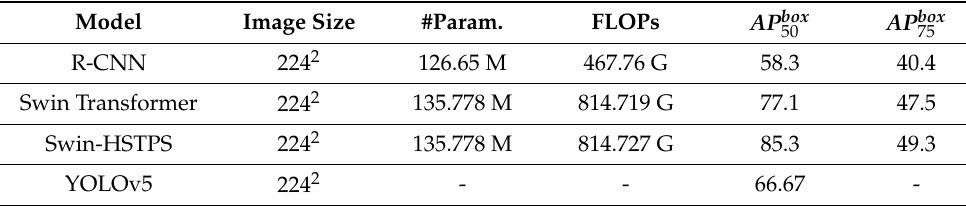
Table 3. Index comparison table of each target detection model.